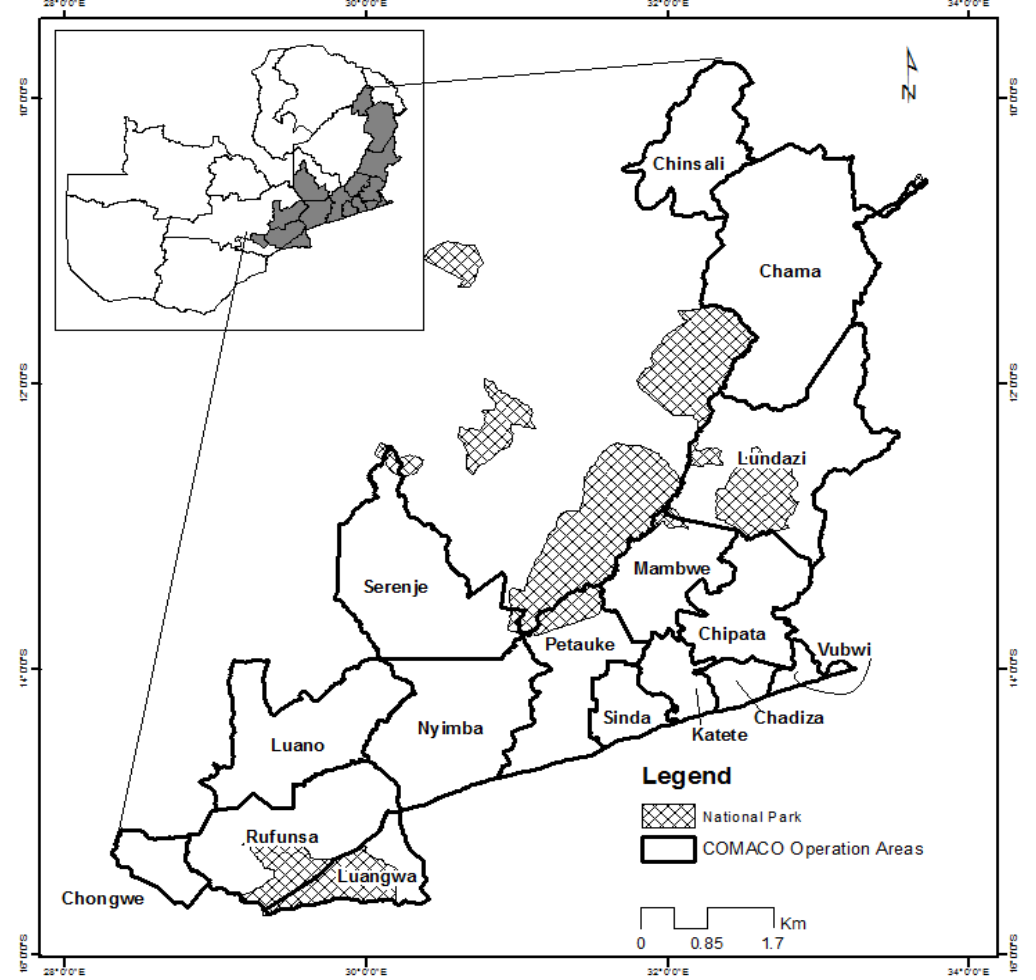
Figure 1. COMACO areas of operation.